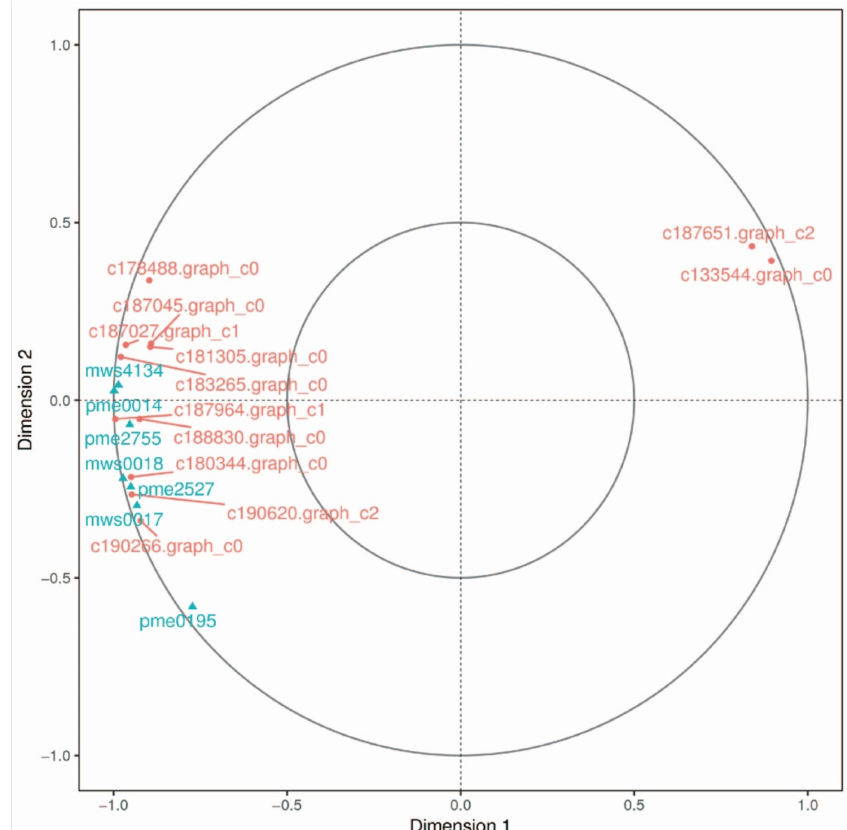
Figure 10. Canonical correlation analysis of Korean pine F and S cell lines and related gene metabolites of GSH. Note: The figure is divided into four regions. The farther away from the origin, the higher correlation will be in the same region, and there is a high degree of correlation between genes and metabolites close to each other in the same